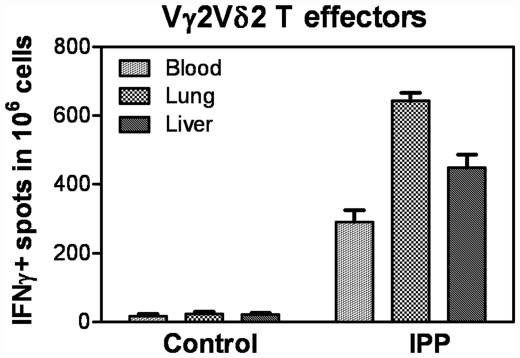
Vγ2Vδ2 T cells that accumulated in tissue compartments could mount effector function and produce anti-TB cytokine.Shown are ELISPOT data for IPP-driven IFNγ+ cellular response in lymphocytes from blood, lung and liver collected from four Mtb-infected macaques at 4–6 weeks after the infection. Data were subtracted from values of glucose/medium control and expressed here as IFNγ+ Vγ2Vδ2 T cells in 10∧6 lymphocytes. IPP stimulates activation of only Vγ2Vδ2 T cells but not other immune cells.